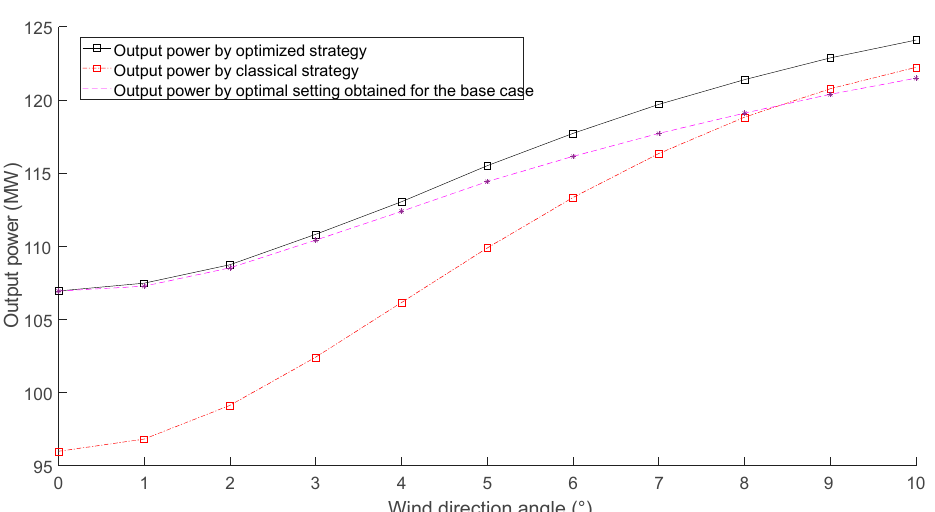
Figure 12. Sensitivity analysis as a function of the incoming wind direction angle. As can be seen, as the angle of the incoming wind direction increases, the lower the power increase obtained with the approach proposed in this work with respect to the classical approach. This is a consequence of the fact that as the angle increases, the rows of wind turbines are less aligned with the incoming wind direction, which reduces the